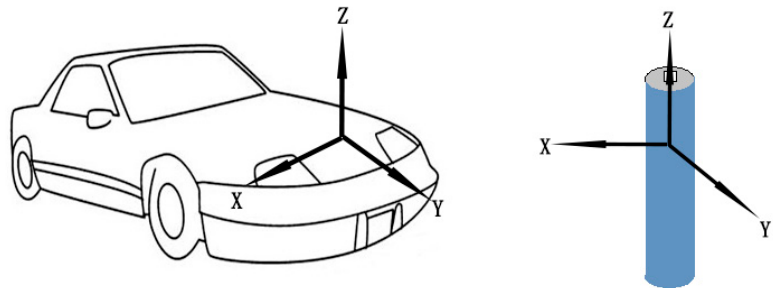
Figure 4. Axis convention of cells.